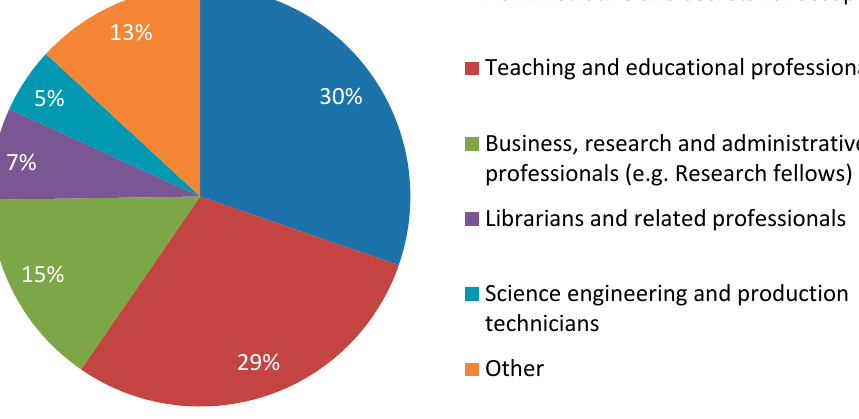
Figure 2. Occupations of Further Education and Higher Education participants.